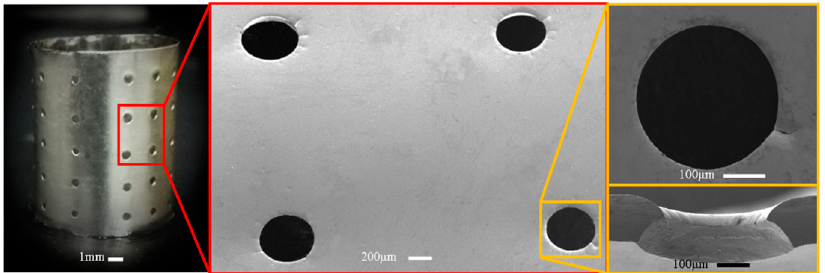
Figure 9. Electroformed seamless hollow cylinder with perforations with hemisphere-cone double- tapered orifices.